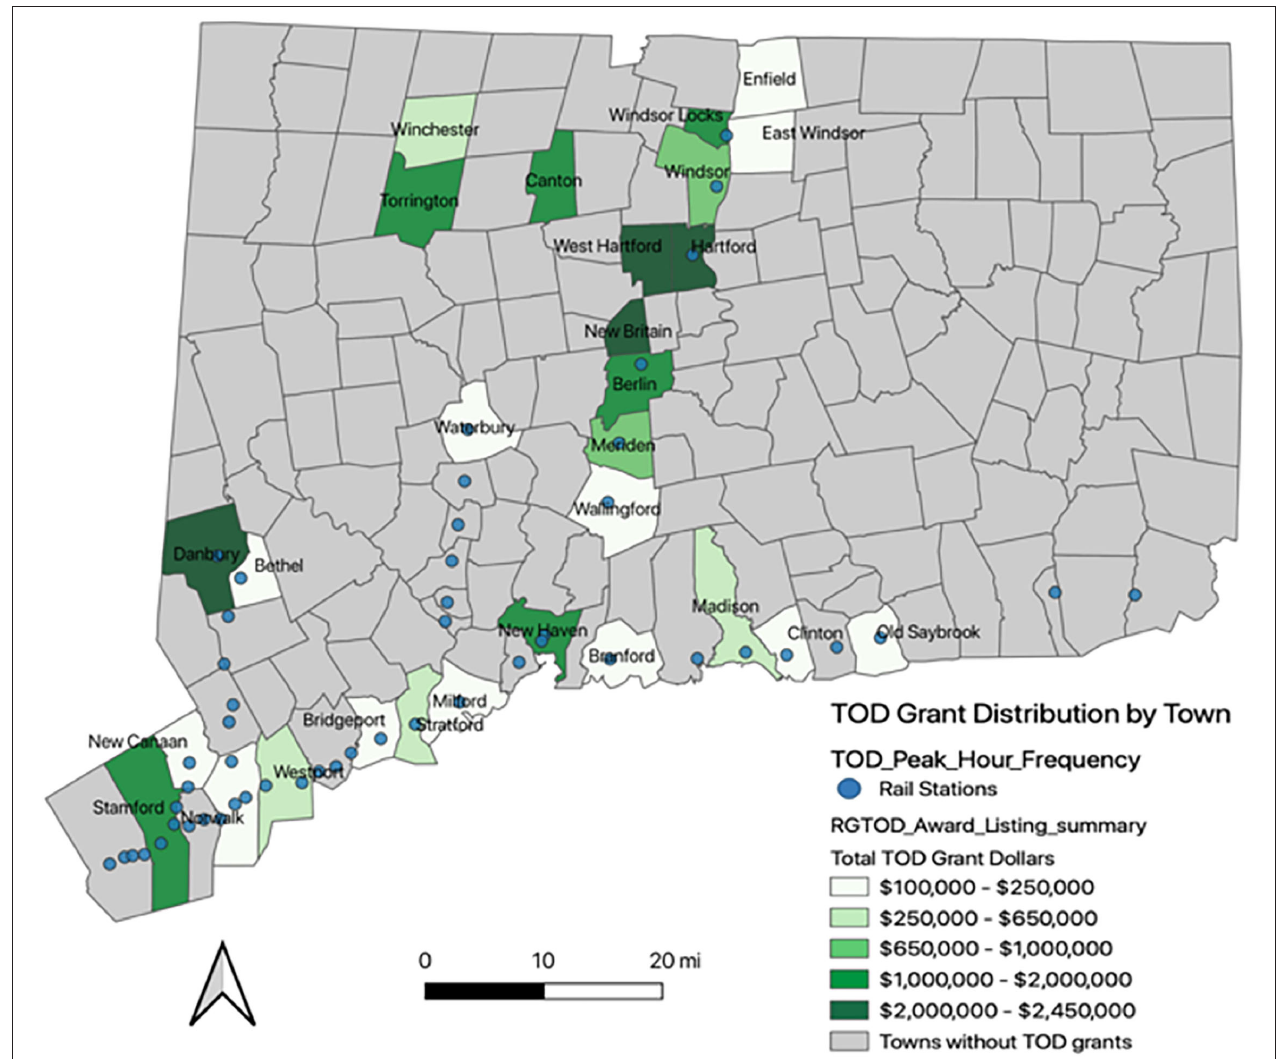
FIGURE 2 | TOD grant distribution by